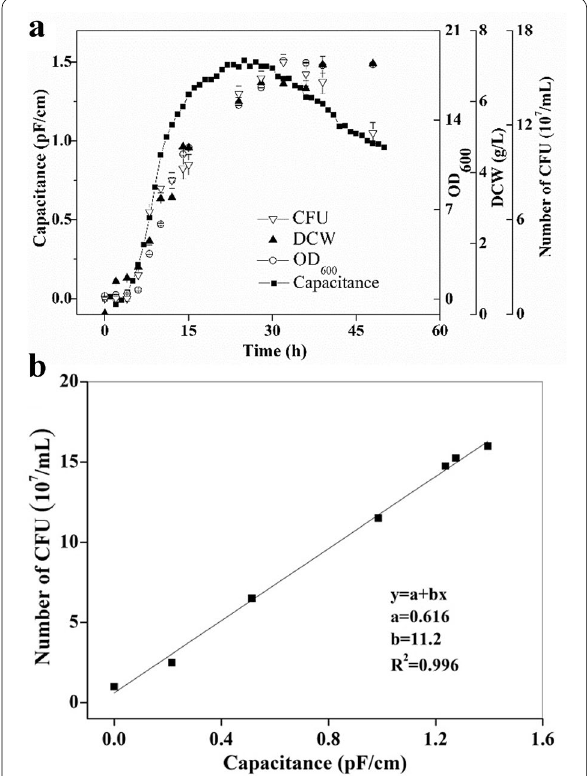
Fig. 2 Time curve of capacitance value and OD 600 , DCW, CFU in a 5-L bioreactor ( a ), capacitance value and CFU ( b